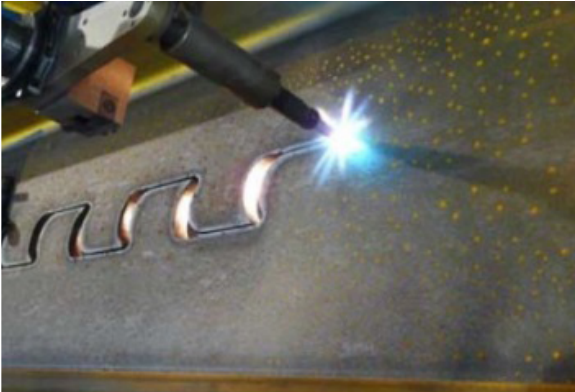
Figure 10: Modification of the SA shape (elimination of sharp notch) [7].